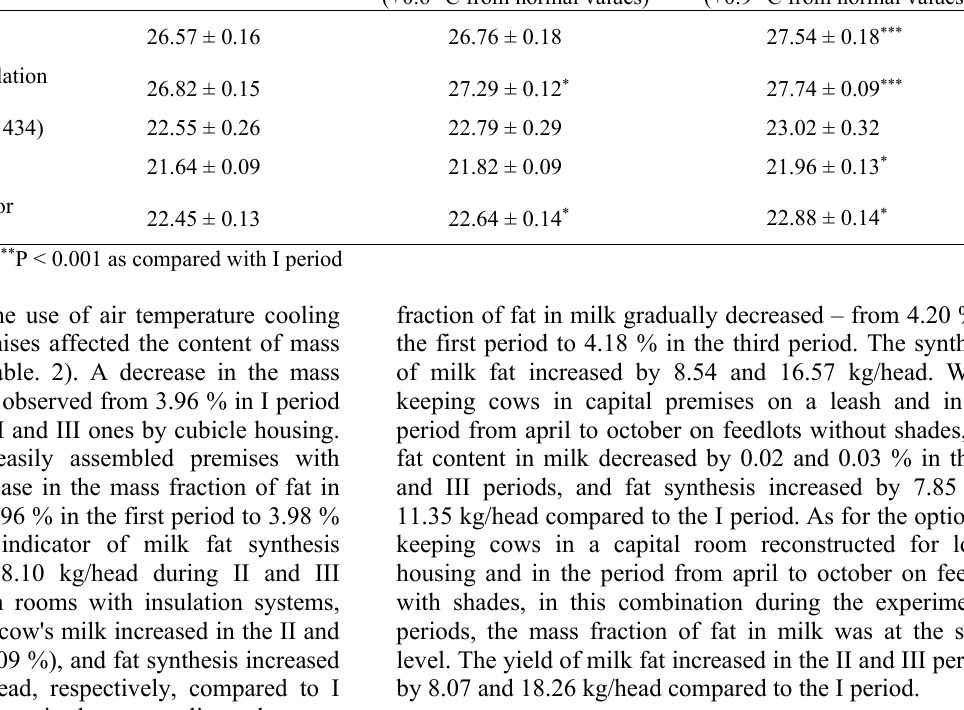
The average daily productivity during during research periods, kg/head Type of facilities and housing